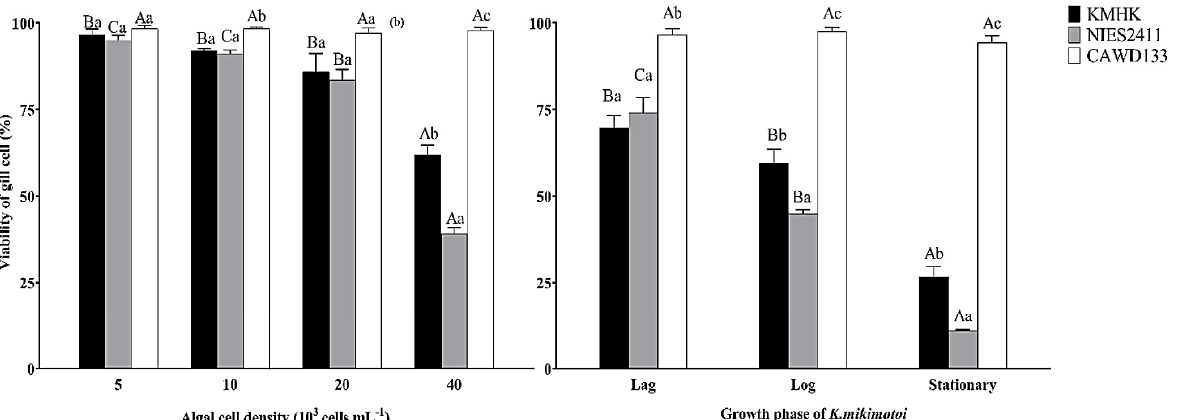
Figure 4. Ichthyotoxicity of three K. mikimotoi strains at different initial algal densities (5 to 40 × 10 3 cells mL − 1 ) and various growth phases (lag, log and stationary phase) in 30 ppt salin- ity to RTgill − W1 gill cells, based on their metabolic activity at 30 min of exposure. For the growth phase experiment, the initial algal cell density of K. mikimotoi was 4 × 10 4 cells mL − 1 and the corresponding days for harvesting the algal cells of each strain at different growth phases were listed in Table A2. Non-toxic algal species Dunaliella tertiolecta (STK − 2) was used as control and no mortality of the gill cells was observed within the 120 min exposure. The capital and small letters indicate statistical results showing significant differences between comparisons. Capital letters indicate significant differences between cell densities or growth phases in the same algal strain, while small letters represent significant differences between three strains of K. mikimotoi at the same cell density or growth phase. Each bar represents the mean ± standard error of mean (SEM) of three true replicates. A 100% gill cell viability was observed in the control experiments with gill cell line exposed to 30 ppt L1 algal medium without any algal cells (data not